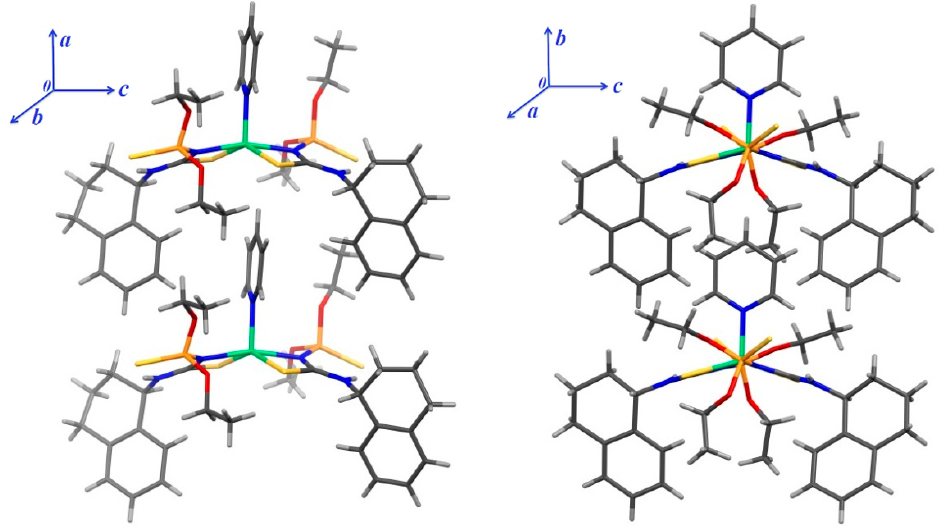
Figure 2. Molecular structure and the arrangement of molecules in homochiral supramolecu lar chains in the crystals of enantiopure ( R,R )-3 ( left ) and racemic 3 ( right ).